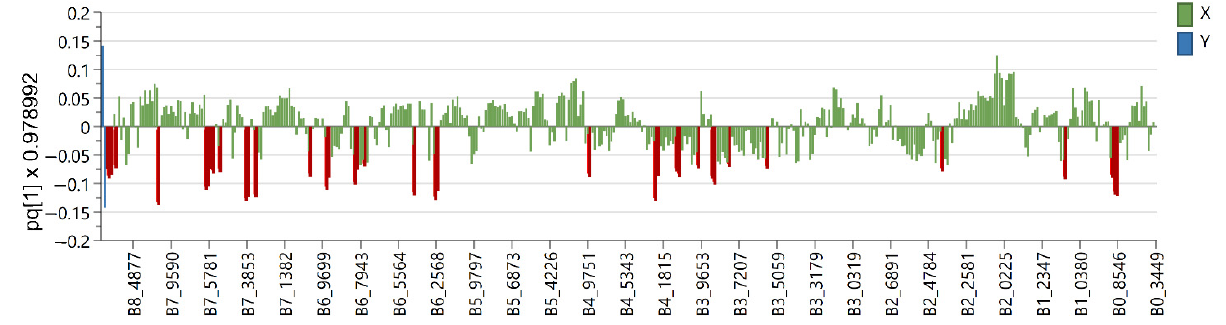
Figure 6. Loading plot with red and brown marked variables characteristic for E. amygdaloides (Y variables—loading vectors scaled to unit length) in comparison to other species (X variables—chemical shift), obtained from the OPLS-DA model.